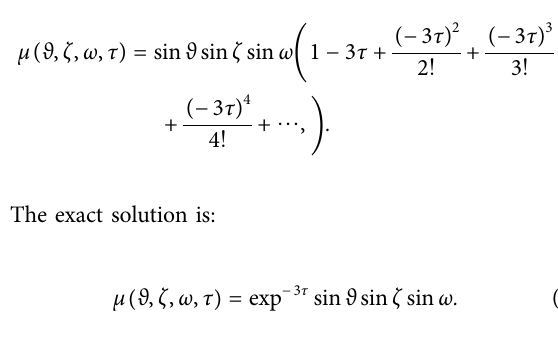
Frontiers in Physics |